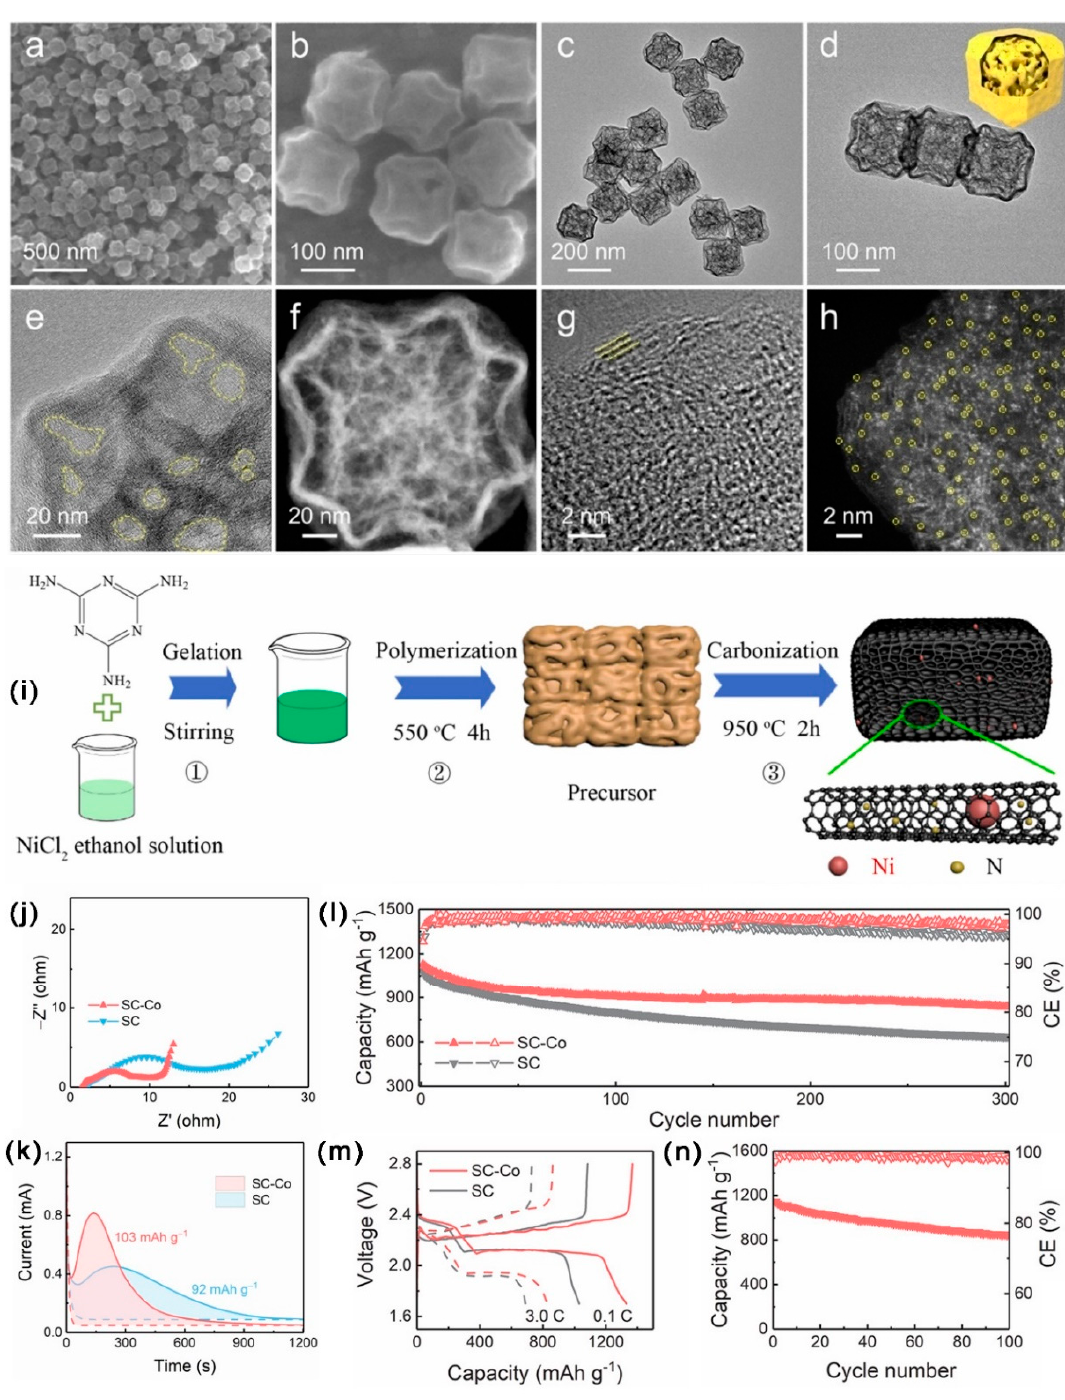
Figure 12. ( a , b ) SEM, ( c – e ) TEM, ( f , g ) HRTEM and ( h ) HAADF-STEM images of Ni-NC(p) (the inset in ( d ) is a schematic diagram of the structure of Ni-NC(p), the markers in ( g ) represent the thin shells of carbon, and the markers in ( h ) represent uniformly dispersed Ni single atoms) [48]. ( i ) Synthesis scheme of the three-dimensional (3D) conductive carbon foams (CFs) [100]. ( j ) Impedance graph of symmetric cells SC-Co electrodes. ( k ) Potentiostatic nucleation curves with SC-Co cathode. ( l ) Cycling performances of LSBs. ( m ) Charging/discharging profiles at different rates. ( n ) Cycling performances under the circumstance of a high S loading cathode up to 3.6 mg cm − 2 [45].